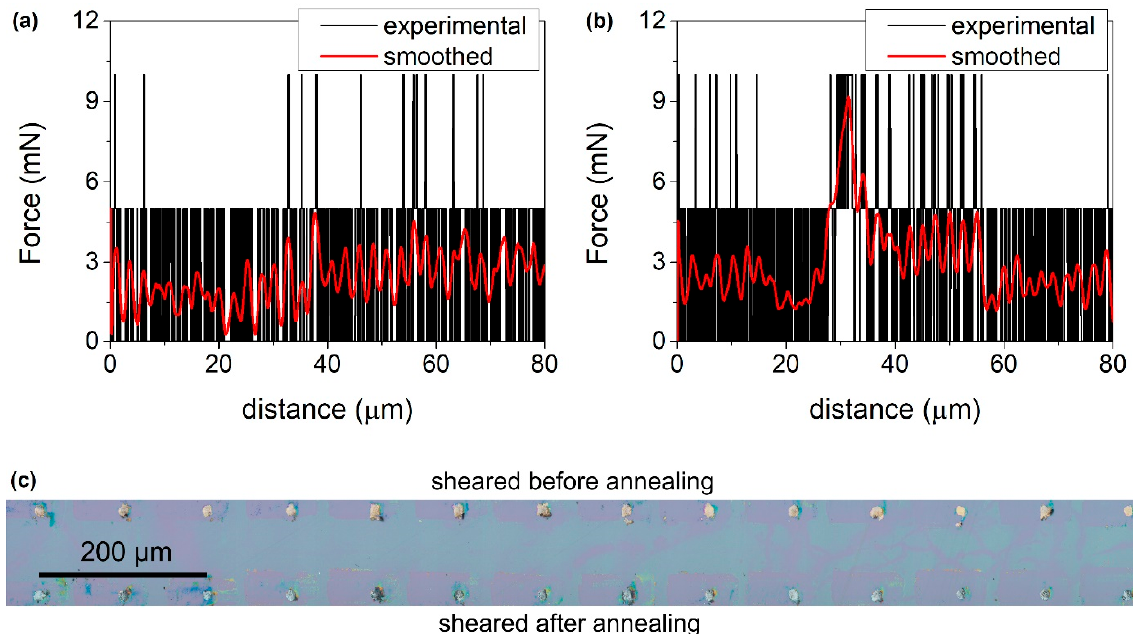
Figure 6. Force versus distance data for 35 μ m in diameter indium columns before ( a ) and after ( b ) annealing (black line—experimental data, red line—the result of adjacent-averaging processing). ( c ) Optical microscope image of residues after shearing of indium columns.